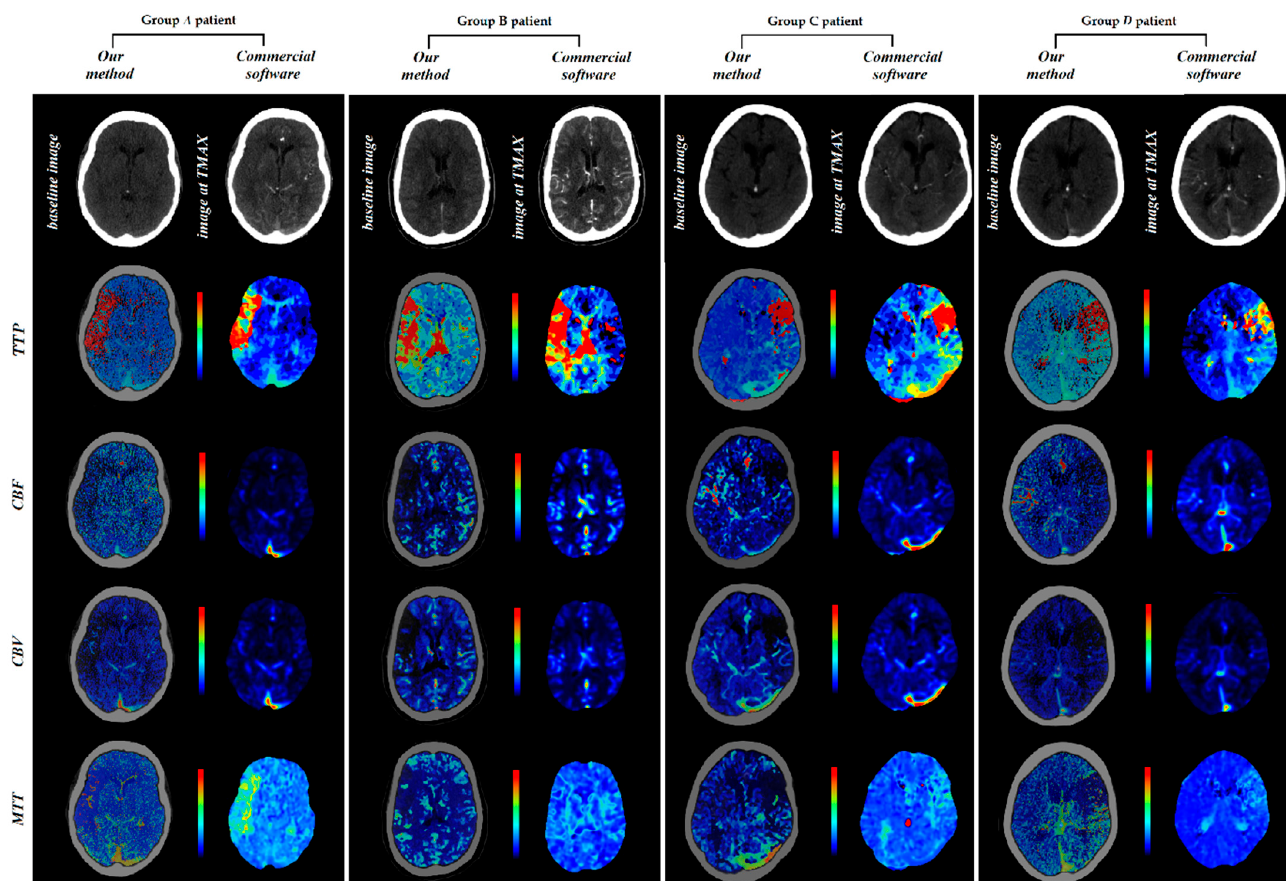
Figure 3. Perfusion maps calculated using in-house-developed software and commercial software.